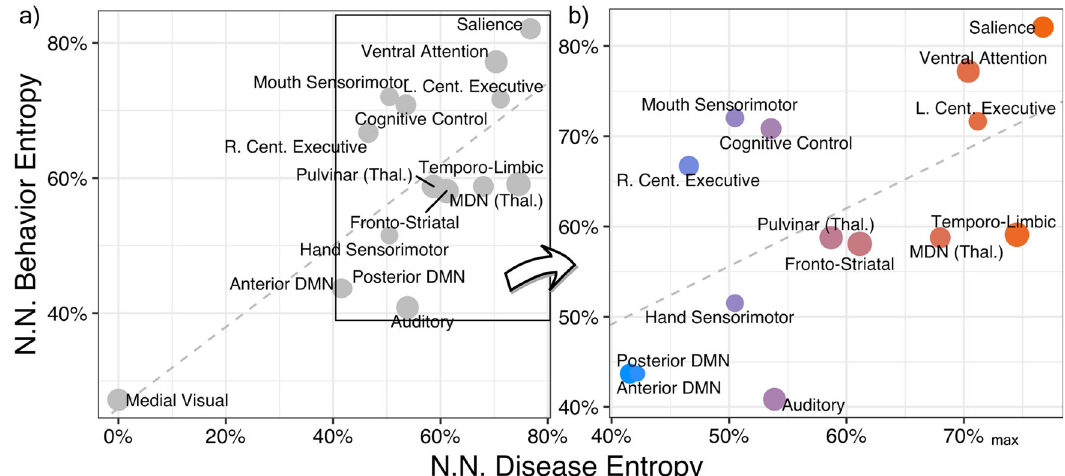
Fig. 3 Matched network disease and behavior entropy comparison. The informational content of each network in terms of percent maximum of network normalized behavior and disease entropy. High disease entropy corresponds to a network that is associated with a higher variety of diseases [from n = 43 International Classi fi cation of Disease (10th version) diagnostic categories] and is non-speci fi c to one or few diseases. High behavior entropy corresponds to a functional network associated with a high variety of Behaviors (from n = 56 BrainMap behavior domains) and is also not specialized. Only those n = 15 networks that are signi fi cantly matched between co-alteration and task-activation ICA are displayed; the size of data points is proportional to their spatial correlation (0.31 ≤ r ≤ 0.62). The linear model a had the following parameters: β = 0.60; p = 0.0006; df = 13; Adjusted R 2 = 0.53. Panel b excludes the medial visual network from view, where color corresponds to the fi tted values of the model. NN network normalized, MDN medial dorsal nucleus, DMN default-mode network, Thal. thalamus, L./R. left/right, Cent. central. Source data are provided in Supplementary Data